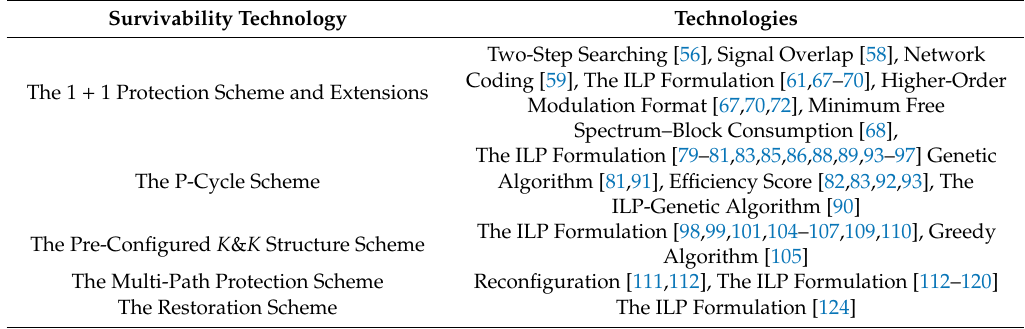
Table 2. Technologies used to minimize backup spectrum